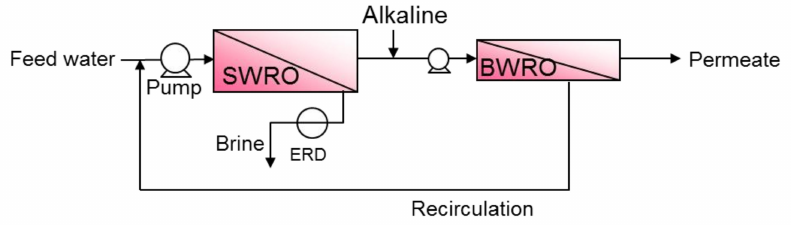
Figure 5. The basic flow configuration of the two-pass system. Alkaline is usually dosed into SWRO permeate at the first pass (i.e., feed water of the second pass) to enhance boron